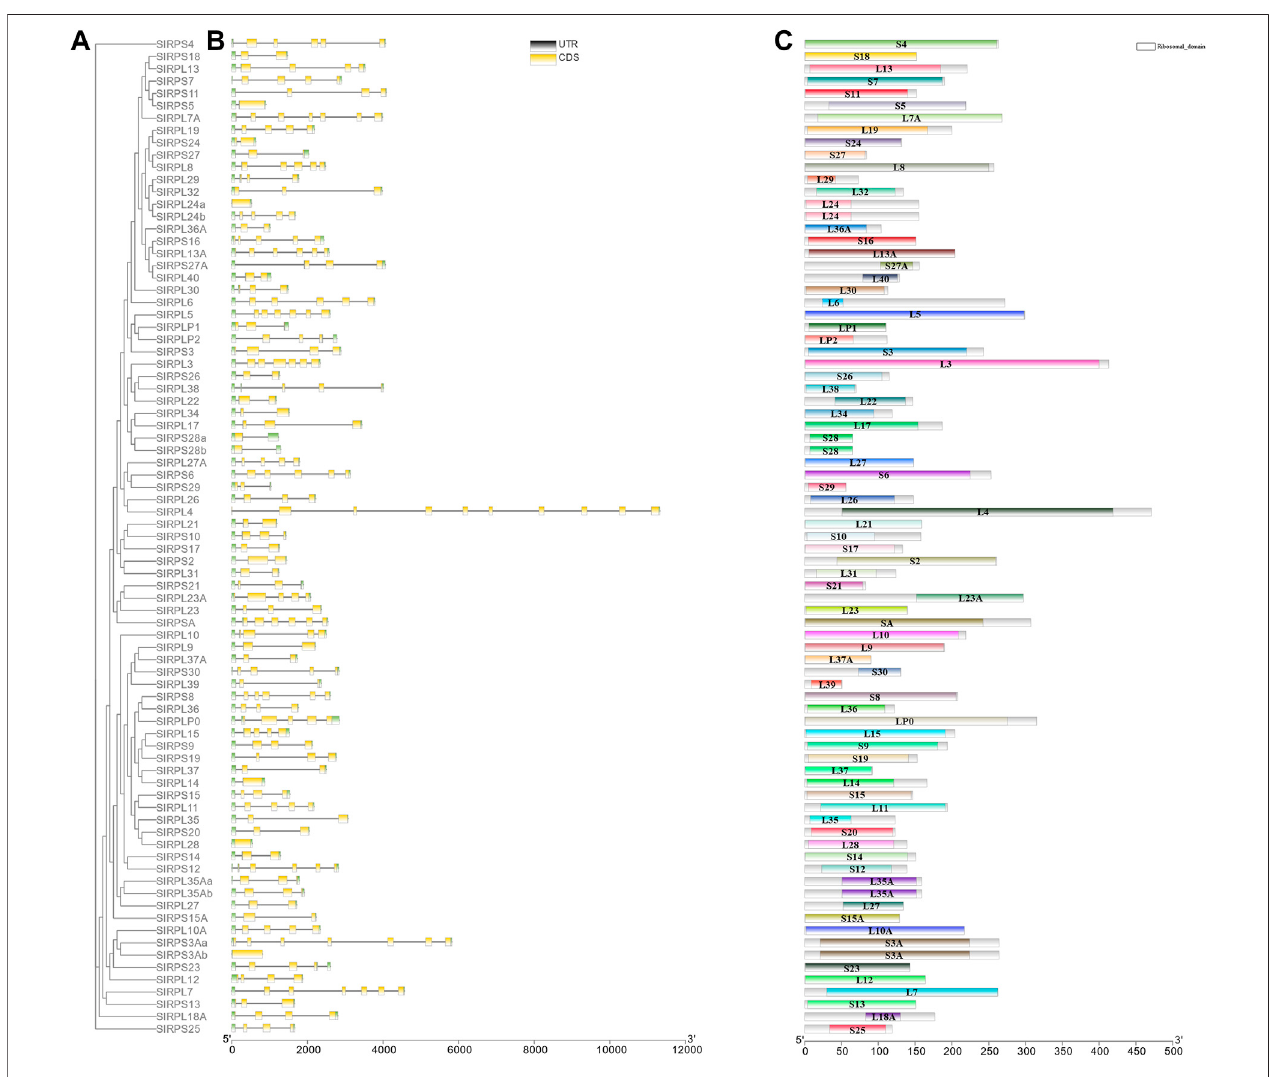
FIGURE 4 | Phylogenetic relationship, motifs analysis, and gene structure of SlRp genes. (A) , the ML phylogenetic tree based on Sl Rps; (B) , Exon-intron structure of SlRp genes. Blackish-grey lines indicate introns and green boxes indicate UTR regions, and yellow rectangles indicate the position of SlRp CDS domains; (C) , Conserved domains of Sl Rps were predicted in smart database, and different-colored squares represent different domains of Rps.